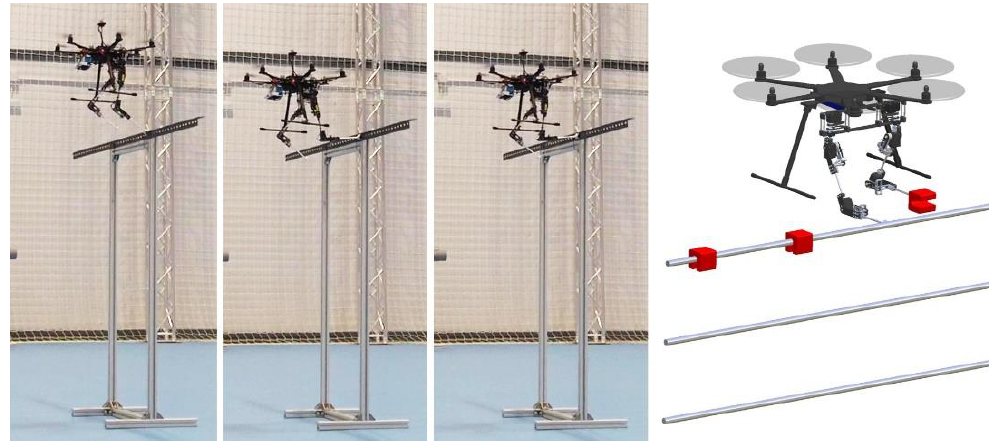
Figure 1. Dual arm aerial manipulation robot grabbed a linear structure with the right (grabbing)